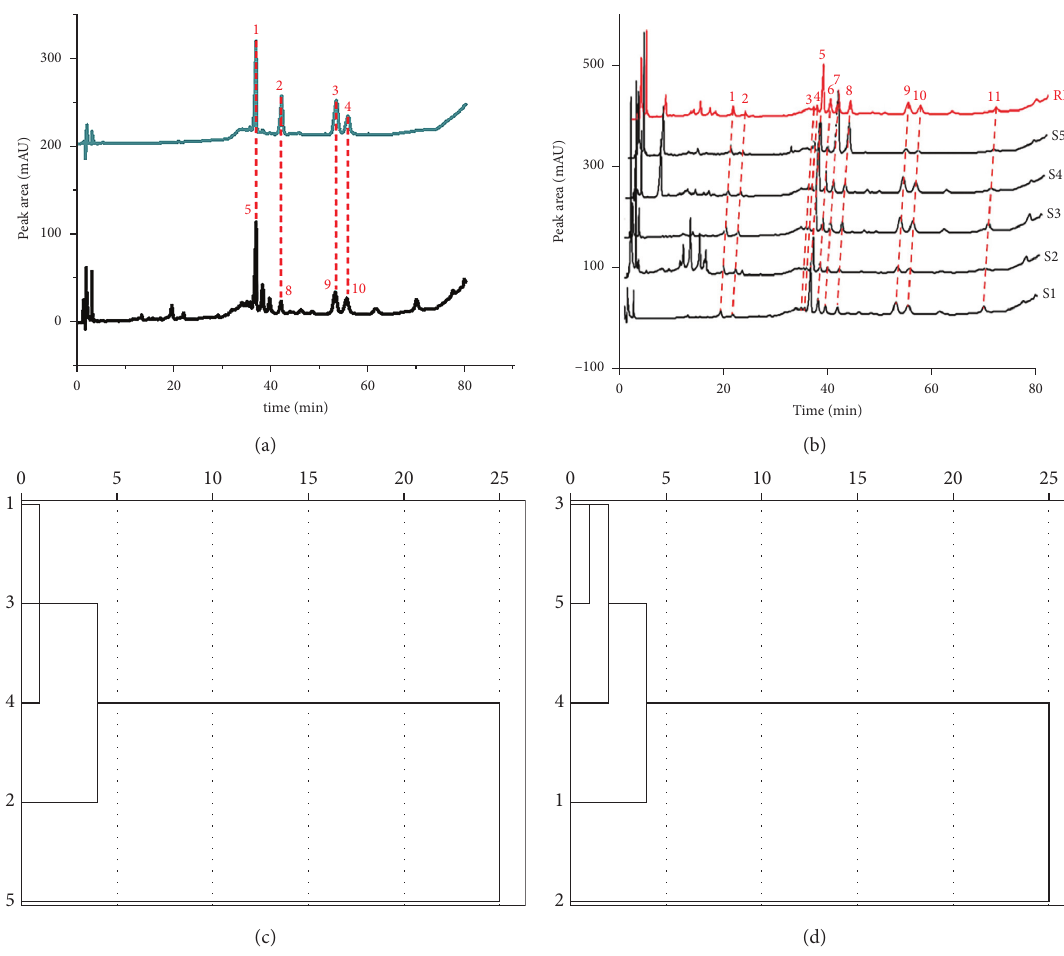
Figure 3: Peak positions of 4 markers in the chromatograms (a). HPLC fingerprints of 5 batches of Pulsatilla chinensis total saponin extracts (b). Dendrogram of HCA with peak area as variable (c). Dendrogram of HCA with P m as variable